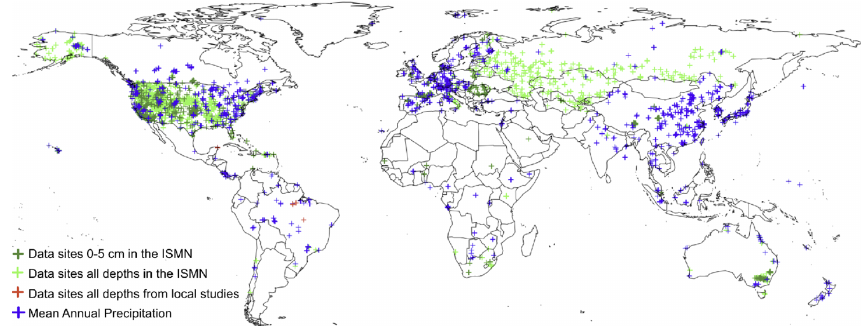
Figure 1. Spatial distribution of available data from in situ monitoring sites. This information was only used for validating our soil moisture predictions. The ISMN (green for all data sites and dark green for sites with available information at 0–5cm), precipitation records (blue), and soil moisture additional datasets from previous local studies